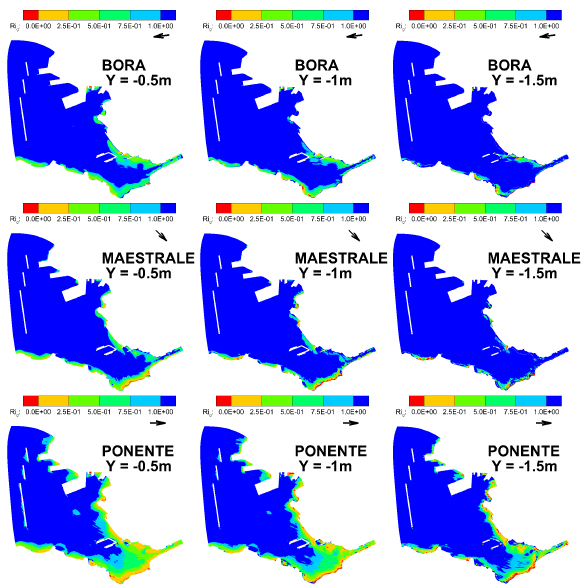
Fig. 22. Contour plot for the gradient Richardson number, averaged on a time of 3 hours, at three horizontal levels. From top to bottom the plots refer to Bora, Maestrale and Ponente scenarios.